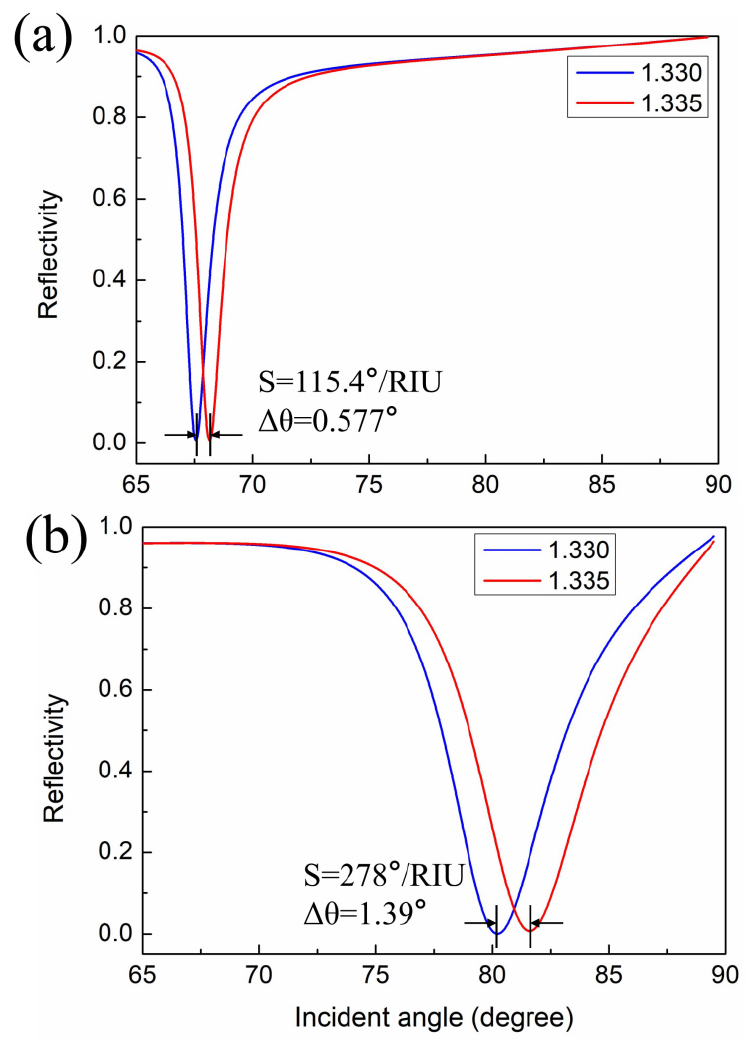
Figure 3. The change in resonance curves versus the angle of incidence for ( a ) conventional SPR sensor; ( b ) the proposed SPR sensor.